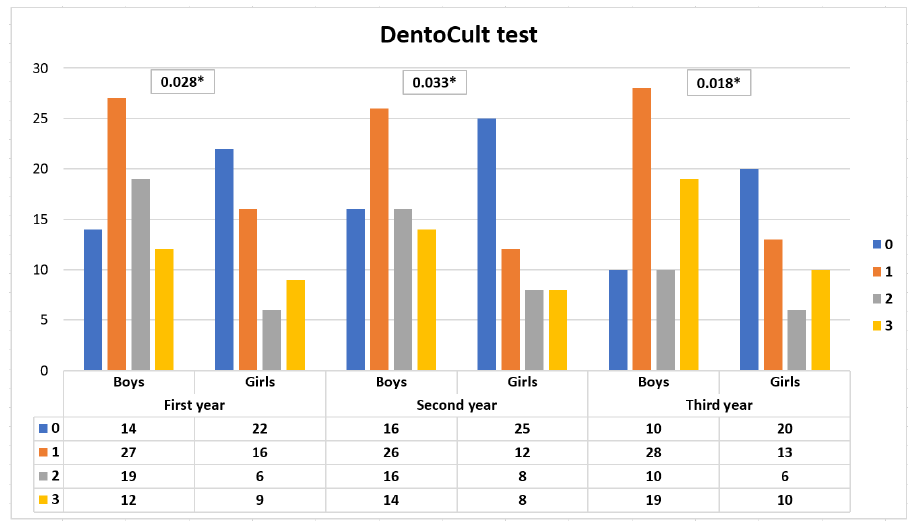
Figure 1. DentoCult SM test scores of boys and girls in the first, second, third year of the study. The statistical analyses were performed using the Chi-squared test. * p > 0.05.